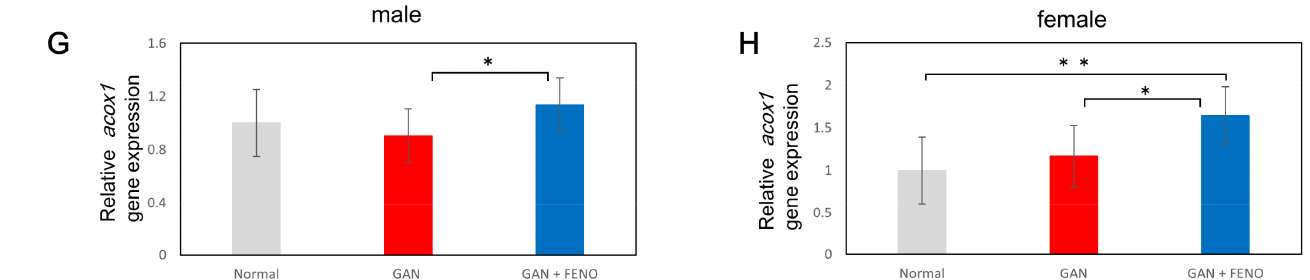
Figure 6. Changes in body weight, liver weight, and liver–weight ratio due to fenofibrate administration. ( A , B ) Changes in body weight after administration of each feed; ( C , D ) Liver weight three months after administration of each diet; ( E , F ) Liver–weight ratio three months after administration of each diet; ( G , H ) Gene expressional analysis of acox1 ; ( A , C , E , G ): male; ( B , D , F , H ): female. Data are represented as the mean ± standard deviation (SD) ( n = 10). * indicates significant difference ( p < 0.05), ** indicates significant difference ( p < 0.01).